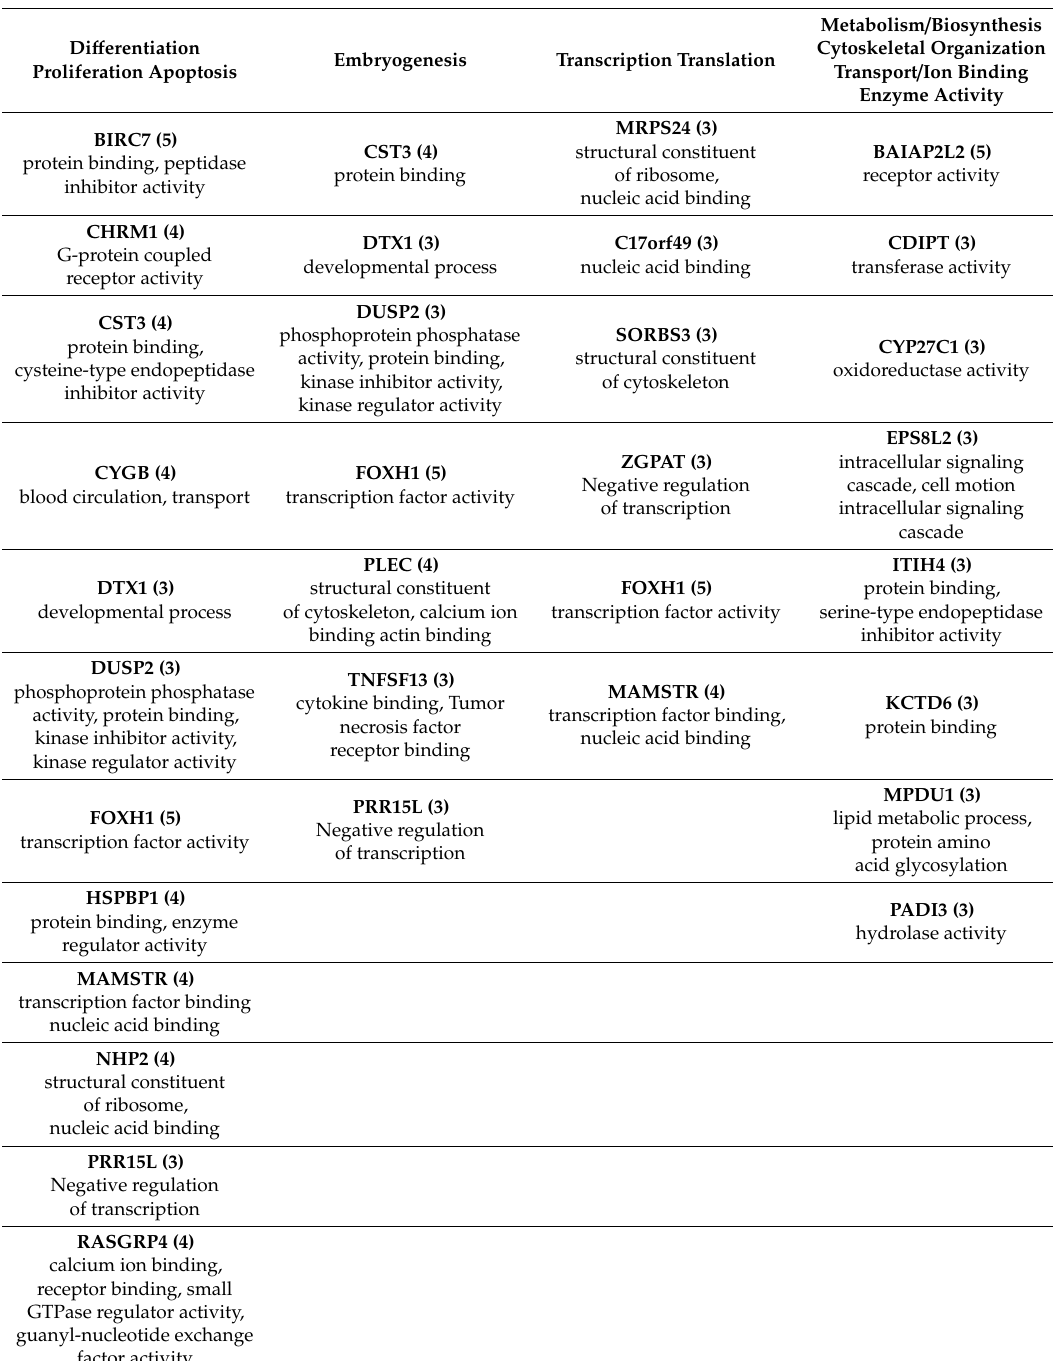
Table2. Functional classificationof iM-forming geneswith threeor more5hmCs within aG4 / iM-forming sequence upstream of the TSS. The number of 5hmCs present is given in